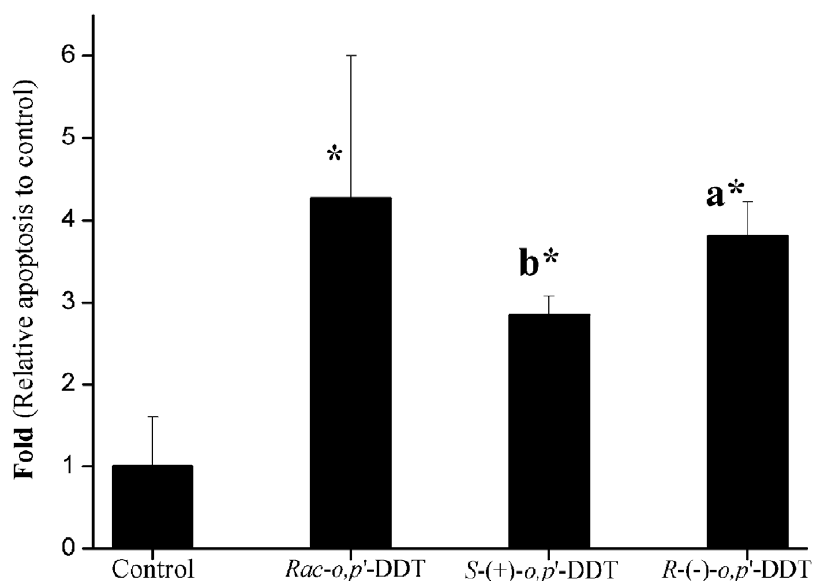
Figure 3. Enantioselectivity in DDT-inducted apoptosis in PC12 cell. The percent of early apoptotic cells following treatment with individual enantiomers or racemate of DDT was measured with flow cytometry quantified by Annexin V (AV)-PI staining.